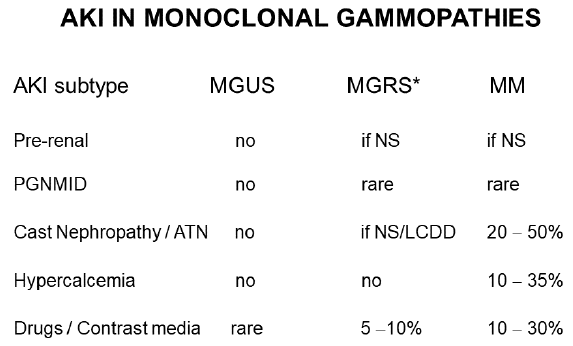
Figure 1. Major types of acute kidney injury complicating monoclonal gammopathies (MG), including forms of unknown significance (MGUS), forms with renal significance (MGRS), and hematologic malignancies such as multiple myeloma (MM). Prevalence data vary among different case series in the literature (range is given). Abbreviations: NS, nephrotic syndrome; PGNMID, proliferative glomerulonephritis with monoclonal Ig deposits; ATN, acute tubular necrosis; LCDD, light chain deposition disease. Drugs/agents potentially causing AKI include nonsteroidal anti-inflammatory drugs, radi- ological contrast media in the presence of significant blood levels of MC protein, or chemotherapy agents for MM as listed in Table 3. * In MGRS, NS may occur as a consequence of amyloidosis (without a bone marrow evidence of MM); similarly, LCDD with high levels of circulating MC protein may cause “cast” nephropathy.